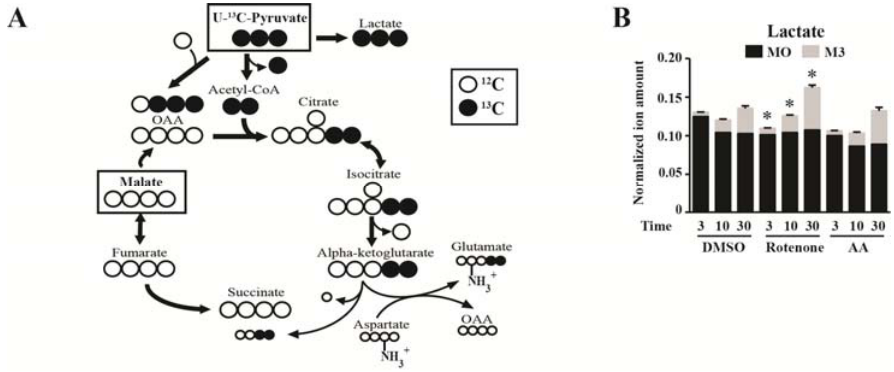
Figure 3. Stable isotope tracer analysis in skeletal muscle mitochondria treated with mitochondrial inhibitors and incubated with 13 C-pyruvate and unlabeled malate as respiratory substrates. ( A ) Diagram depicting carbon cycling into the citric acid cycle (CAC). Substrates used during mitochondrial incubations are shown in boxes. 13 C labeling is black and 12 C is sulfoxide (DMSO), rotenone and antimycin A (AA) treatments of isolated murine skeletal U- 13 C-pyruvate and unlabeled malate. Isotopic enrichment for lactate ( B ), oxaloacetate ( C ), citrate ( D ), alpha-ketoglutarate ( E ), succinate ( F ), aspartate ( G ) and glutamate ( H ) are (M3) enrichments  SEM of 4 independent experiments. * p < 0.05, one-way